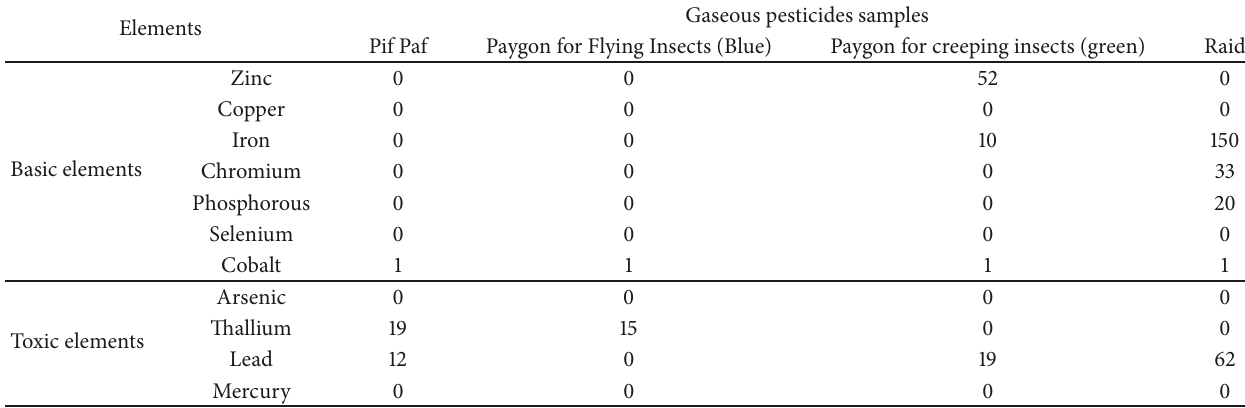
Table 3: The percentage (ppb) elements in the gaseous insecticides samples. Gaseous pesticides samples Elements Pif Paf Paygon for Flying Insects (Blue) Paygon for creeping insects (green) Raid 0 52 0 0 0 0 10 Basic elements